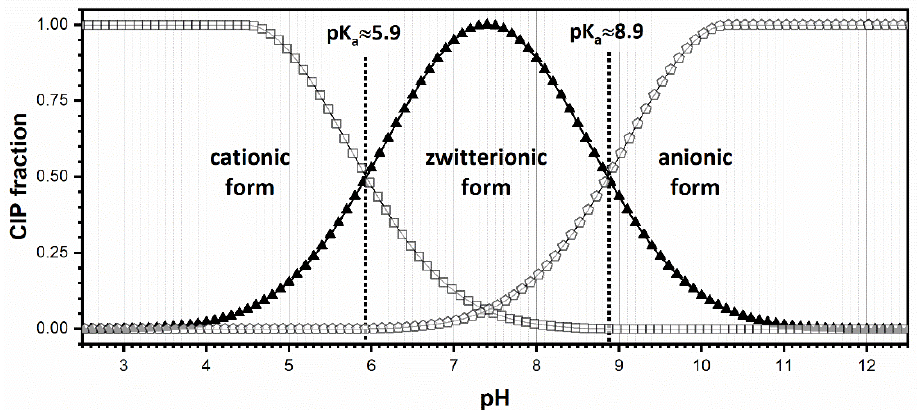
Figure 12. Molecular structure of CIP and its ionic forms as a function of pH and pKa values, drawn after image from [56].